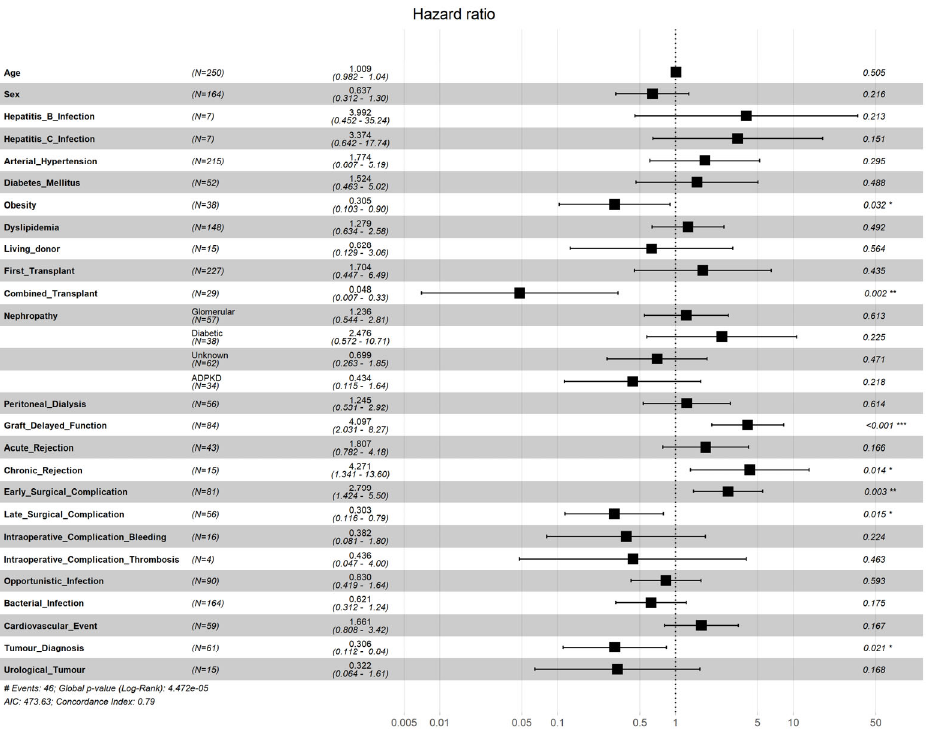
Figure 6. Results of the Cox proportional hazards model for graft survival, including the studied variables. * p ‐ value < 0.05, ** p ‐ value < 0.01, *** p ‐ value < 0.001.